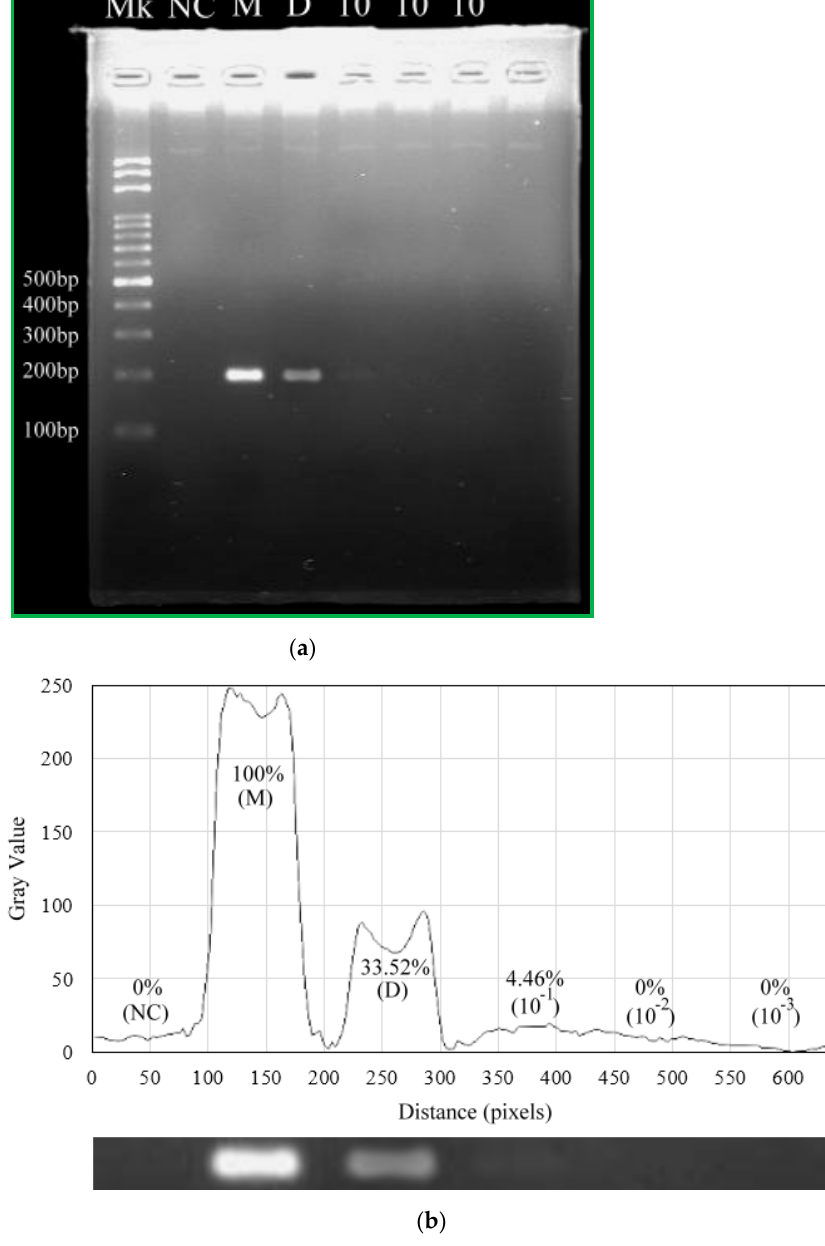
Figure 13. ( a ) The results of gel electrophoresis analysis of the products. The first lane (Lane Mk) indicates the DNA ladder. The second lane (Lane NC) indicates the negative control from the CFPCR chip. The 200 bp PCR product in the commercial PCR machine and CFPCR chip (Lanes M, D, and the others). ( b ) The grey intensities of PCR products by image analysis.